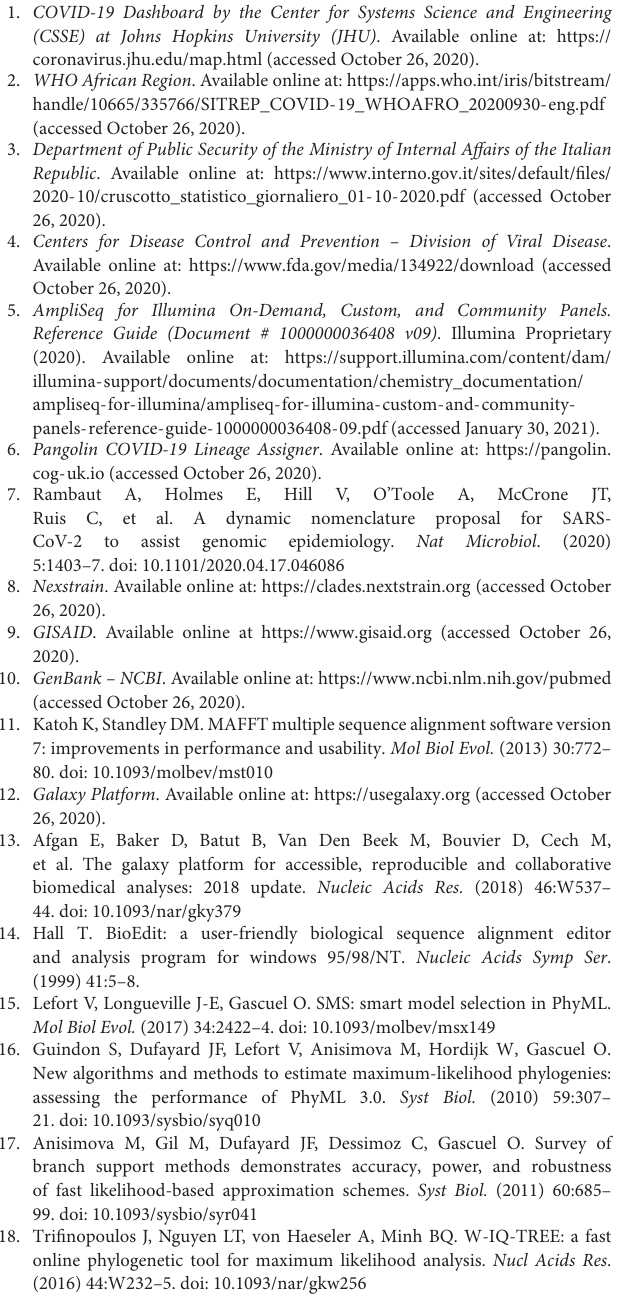
Supplementary Table 1 | Sequences used in this study and acknowledgment